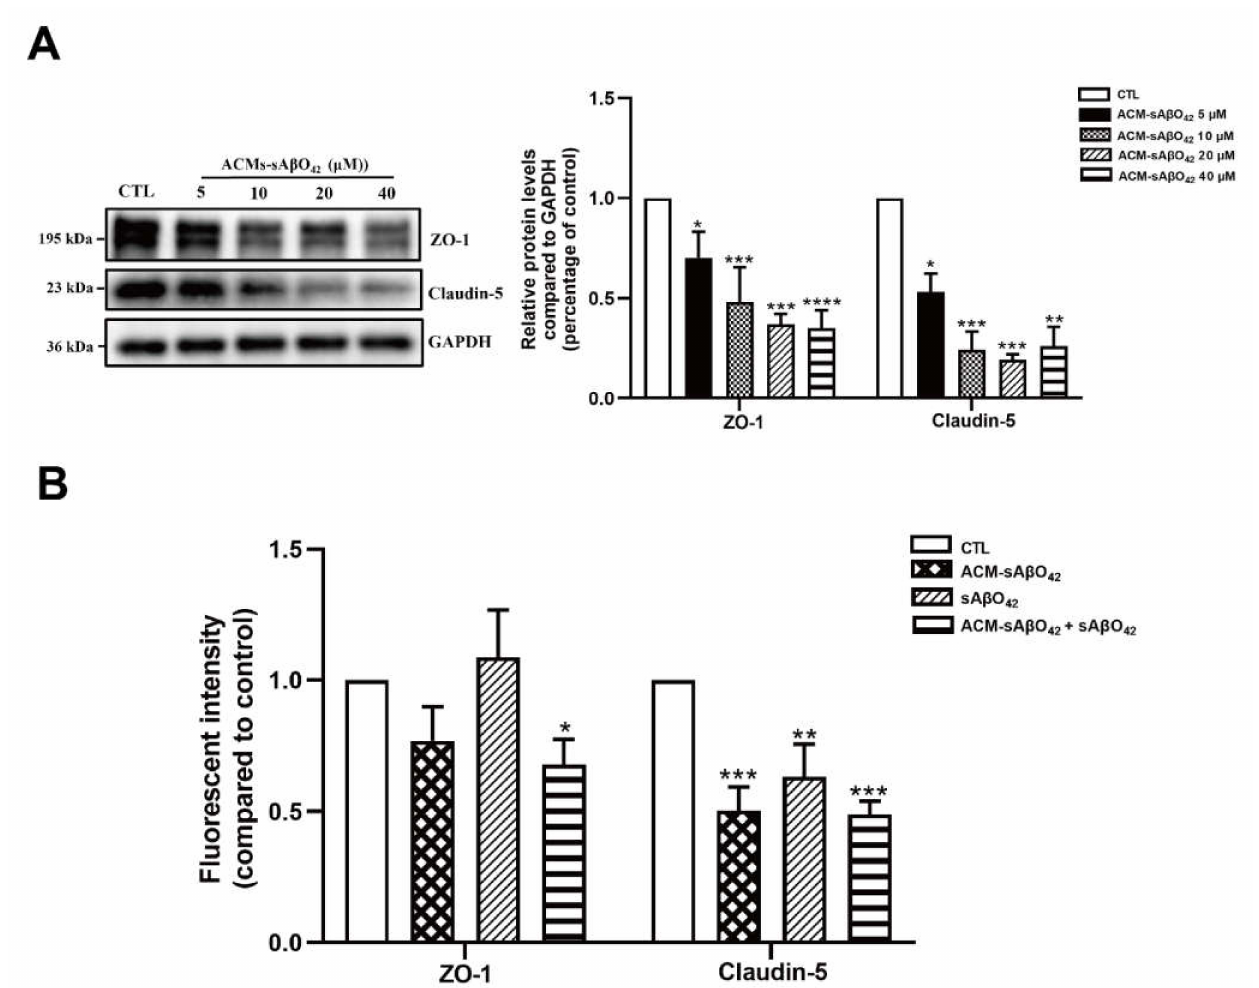
Figure 9. ( A ) Astrocyte secretion stimulated by sA β O42 (ACM-sA β O42) induced significant down- regulation of the protein levels of ZO 1 and claudin-5 in a dose-dependent manner. The protein expression level of ZO-1 and claudin-5 upon the exposure of ACM-sA β O42 (5–40 µ M for 24 h). ( B ) Flu- orescent intensity of junctional proteins ZO-1 and claudin-5 in bEnd.3 cells induced by sA β O42 (10 µ M) and ACM-sA β O42 (10 µ M). Data are shown as means ± SD of at least three independent experiments and were analyzed by one-way ANOVA followed by a post hoc Dunnett’s test. * p ≤ 0.1, ** p ≤ 0.01, *** p ≤ 0.001, **** p ≤ 0.0001 vs. control